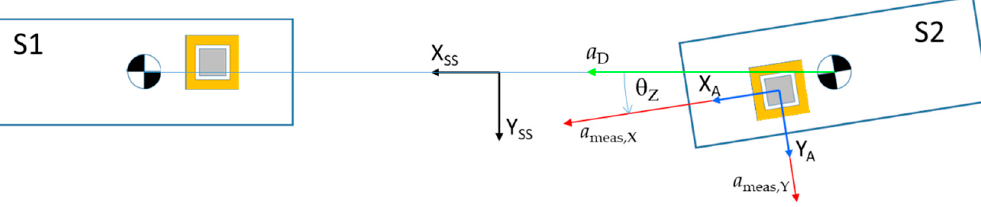
Figure 8. Accelerometer reference frame (X A , Y A , Z A ) to SSRF (X SS , Y SS , Z SS ) misalignment giving rise to the pitch/yaw-dependent error term δ a D .